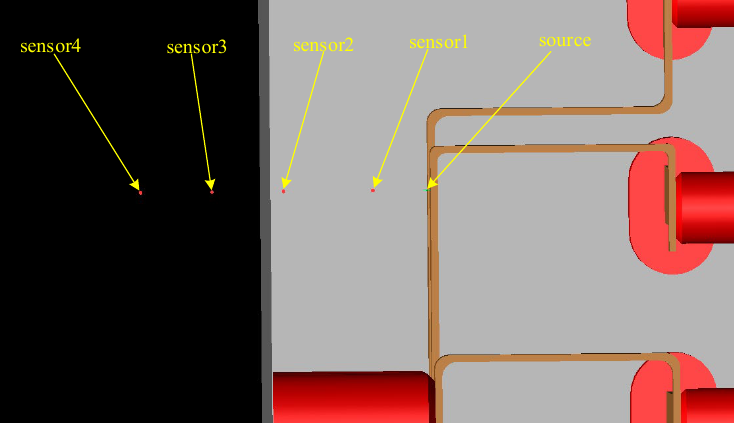
Figure 14. Location distribution of source and point sensors around switchgear wall .